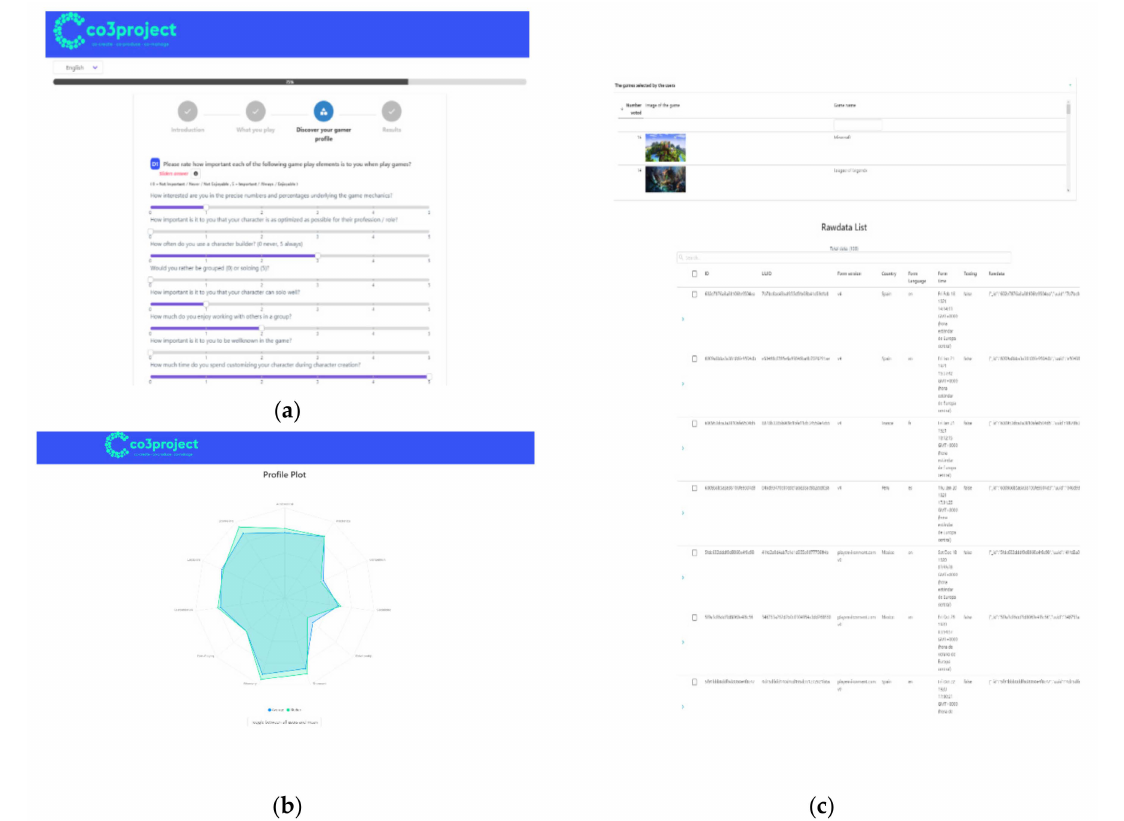
Figure 1. Screenshots of the web interface created for data collection. ( a ) shows a portion of the questions with the sliding selector, from 1 to 5. ( b ) shows the user’s profile in relation to the gamification elements. ( c ) shows the source data stored in a